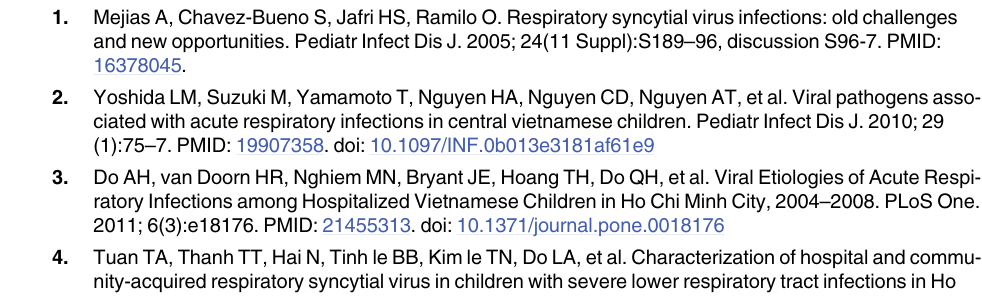
S2 Fig. RSV viral load and day of illness. (A) The first 4 days of illness. (B) Day of follow-up (after day 4 of illness). S1 Table. Viral etiologies identified among RSV co-infection